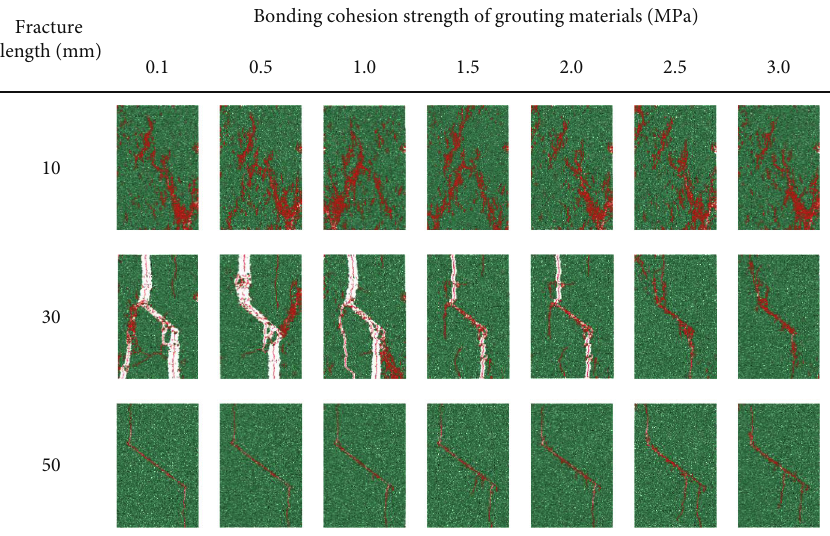
Figure 10: Crack distribution of limestone grouting reinforcement bodies under di ff erent crack lengths and di ff erent bonding cohesion values of grouting stone bodies.